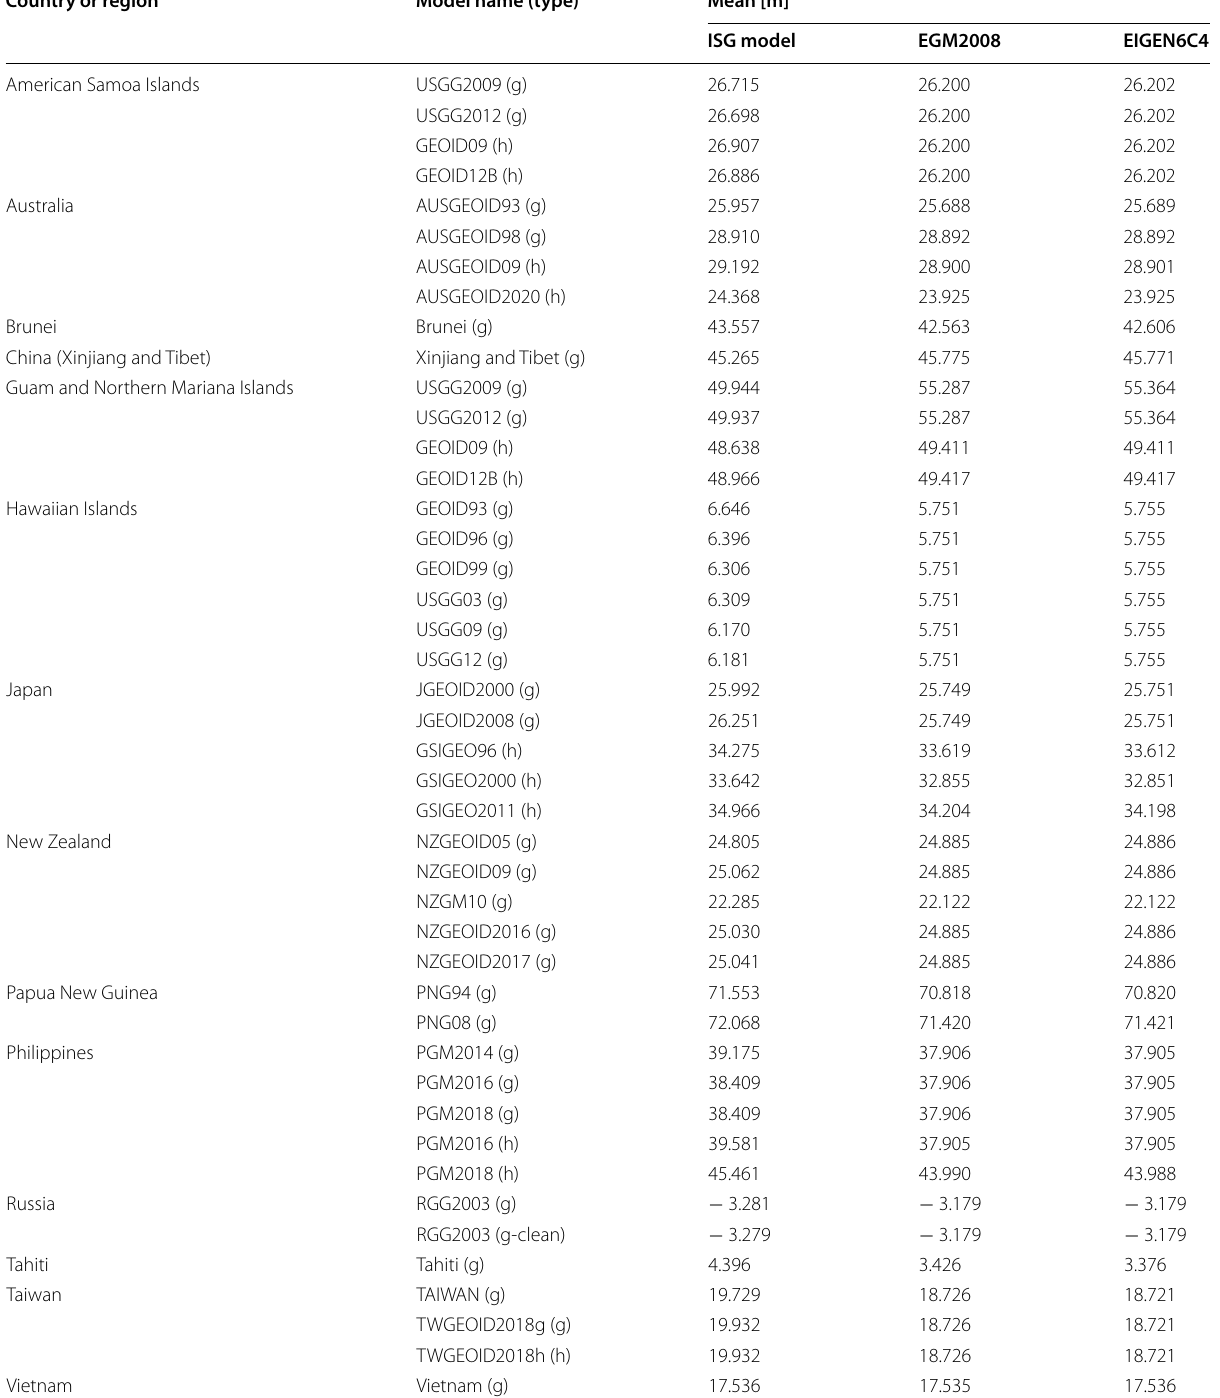
Table 9 Mean values of the Asia–Pacific geoid models available in the ISG repository, as well as those of EGM2008 and EIGEN6C4 global models computed on the same